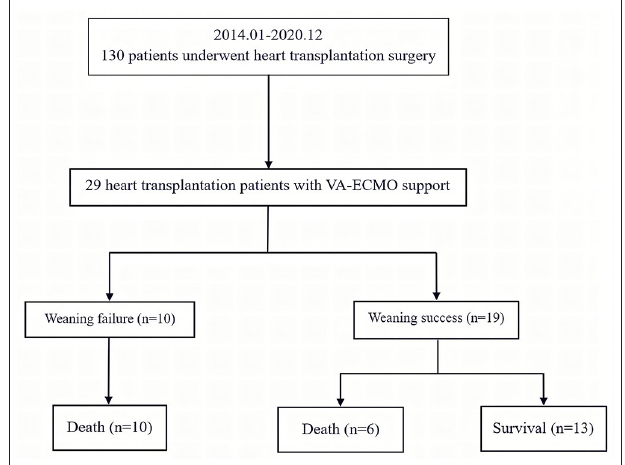
FIGURE 1 | Enrollment, allocation, and follow-up for heart transplant patients who received VA-ECMO. VA-ECMO, veno-arterial extracorporeal membrane